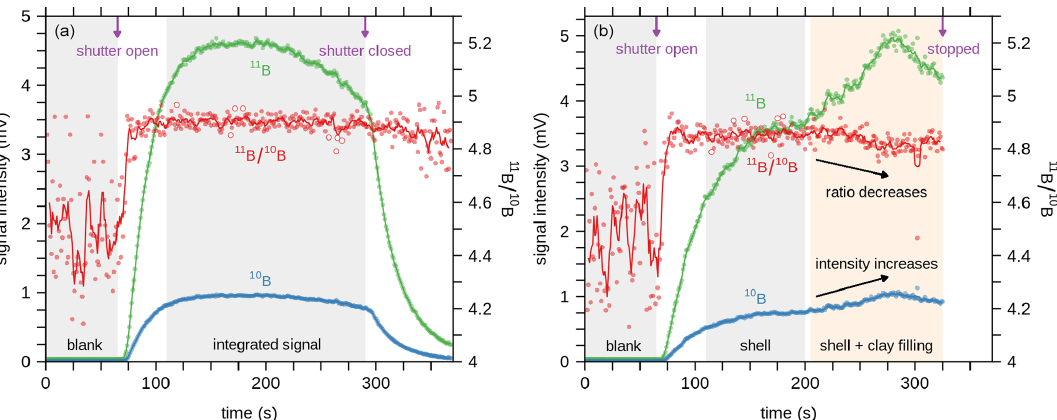
Figure 2. (a) Example of time-resolved laser ablation analysis for 10 B and 11 B of a C. wuellerstorfi shell using Daly detectors, preceded by a ∼ 60s blank measurement. Dots represent 1s cycles, and lines 5-point running averages. Open symbols are data that are excluded by the 2 σ outlier test. (b) Example of a shell that was penetrated by the laser beam, resulting in the ablation of clay